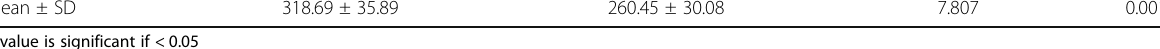
Table 3 Serum level of (IL-2) in both studied groups Serum level of IL-2